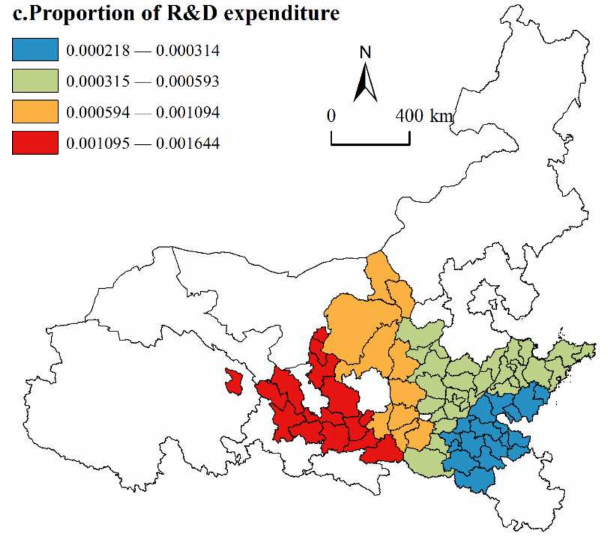
Figure 9. Spatial distribution of proportion of R&D